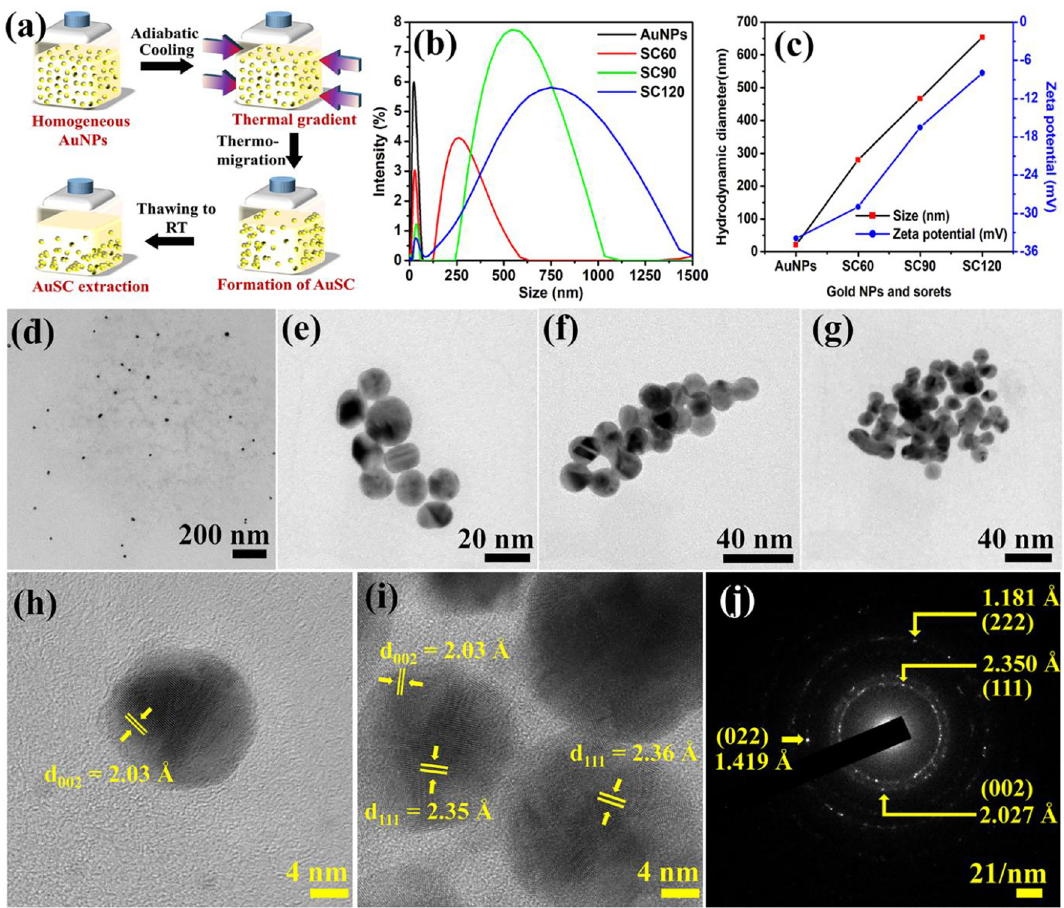
Figure2: (a)SchematicofadiabaticcoolingmethodologyadoptedforsynthesisofAuSCs.Thestepsinvolvedareself-explanatory.(b)DLSsize distribution for different AuSCs. (c) Hydrodynamic diameter and zeta potentials for different AuSCs. (d) TEM image of AuNPs used for AuSC synthesis. TEM images of (e) SC60, (f) SC90 and (g) SC120 clearly indicating the increase in the number of AuNPs per soret as we increase the time of adiabatic cooling. (h) HRTEM image of AuNP indicating the lattice fringes characteristic to gold that does not display assembly formation. (i) HRTEM image of AuSC indicating the lattice fringes characteristic to gold that clearly display formation of assemblies with nanovoids and nanocrevices. (j) SAED pattern of AuSC presenting bright spots characteristic to that of